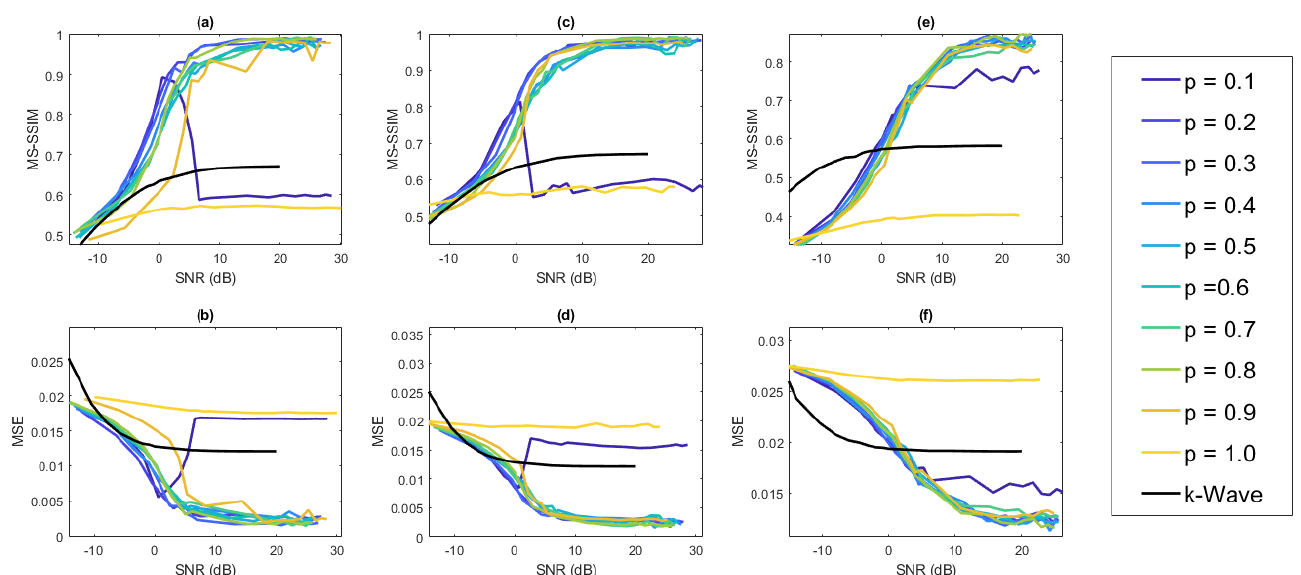
Figure 5. Average MS-SSIM ( a ) and average MSE ( b ) of a cylinder IPD with a radius of six perpendicular to the direction of shearing. Average MS-SSIM ( c ) and average MSE ( d ) of a cylinder IPD with a radius of 6 h parallel to the direction of shearing. Average MS-SSIM ( e ) and average MSE ( f ) of a vessel IPD with ten vessels present. Each point is averaged over five trials for each SNR value considered and is plotted against the SNR value used to calculate the additive Gaussian